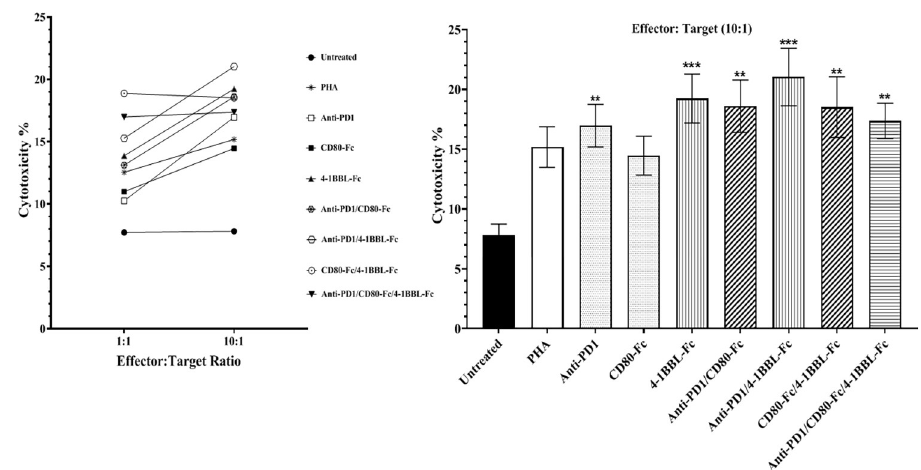
Fig 5. T cells cytotoxicity activity in the presence and absence of anti-PD-1, CD80-Fc, and 4-1BBL-Fc proteins in two types of treatment, namely, mono and combination. CFSE-target cells and effector cells from 6 healthy donors were co-cultured (A) at 1:1 and 10:1 ratios (two-way ANOVA was applied for the data collected) (B) At 10:1 ratio, all of the conditions were compared with the untreated using one-way ANOVA. ( � p � 0.05, �� p � 0.01, ��� P � 0.0001). The column height represents the average percentage of the 7-AAD-positive CFSE-target cells and error bars are ± SEM.